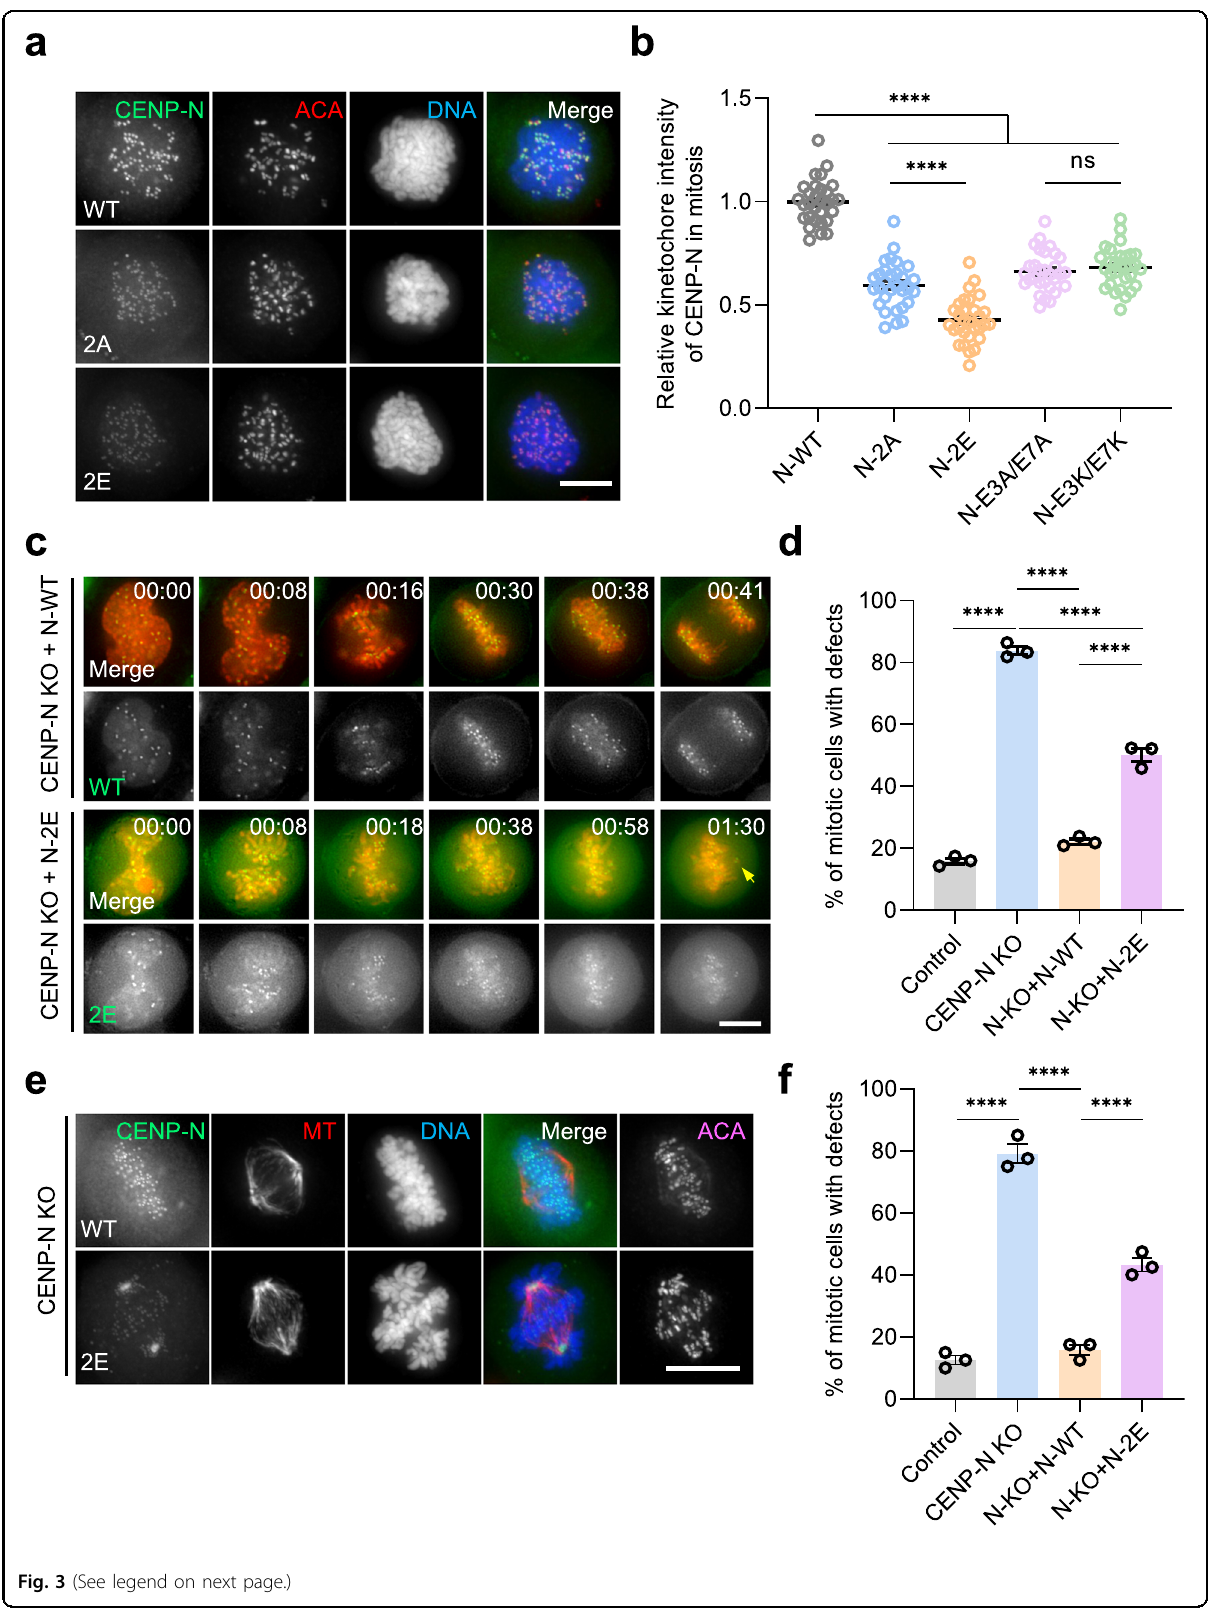
Fig. 3 (See legend on next